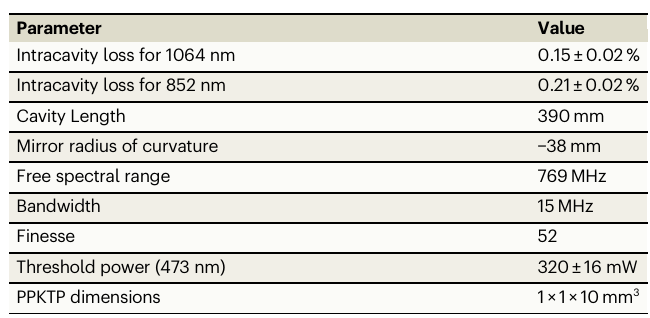
E 2 = E 2 = E 2 =0 : 11±0 : 01 ≪ 1. To the best of our knowledge, this is by 1 ∣ 2 2 ∣ 1